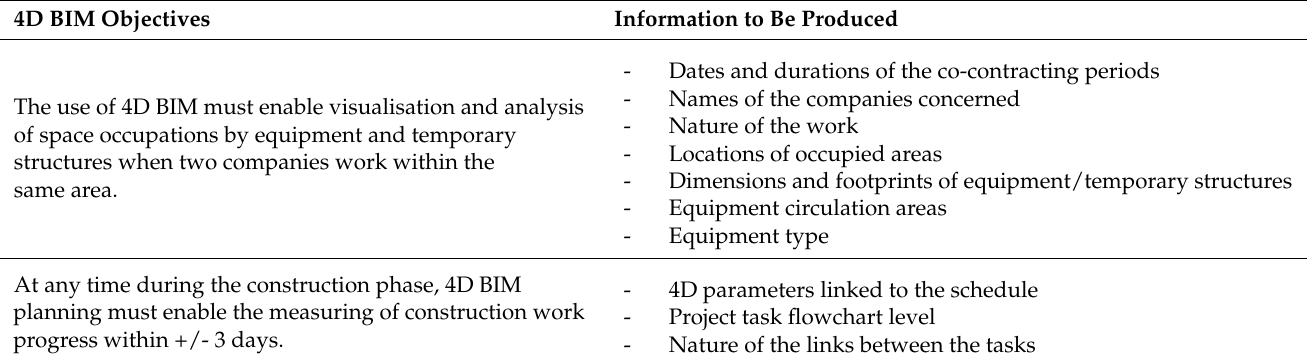
Table 2. 4D information requirements related to the 4D BIM use case.